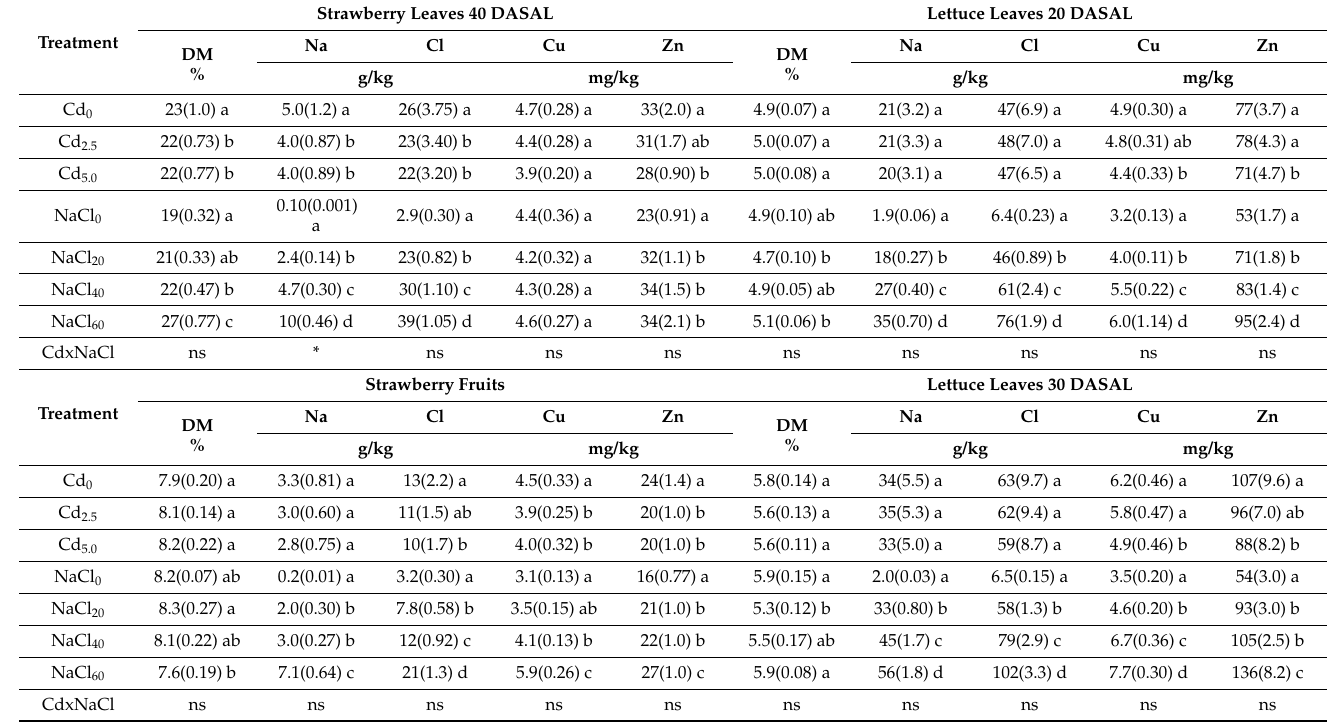
Table 2. Impact of NaCl and Cd treatments on dry matter (DM) percentage and element concentrations in strawberry and lettuce tissues 20, 30 and 40 days after salinity (DASAL) treatment commenced. Means (standard errors in parenthesis; n = 4) with the same letter in a column for a given main effect are not significantly different according to the Tukey’s HSD